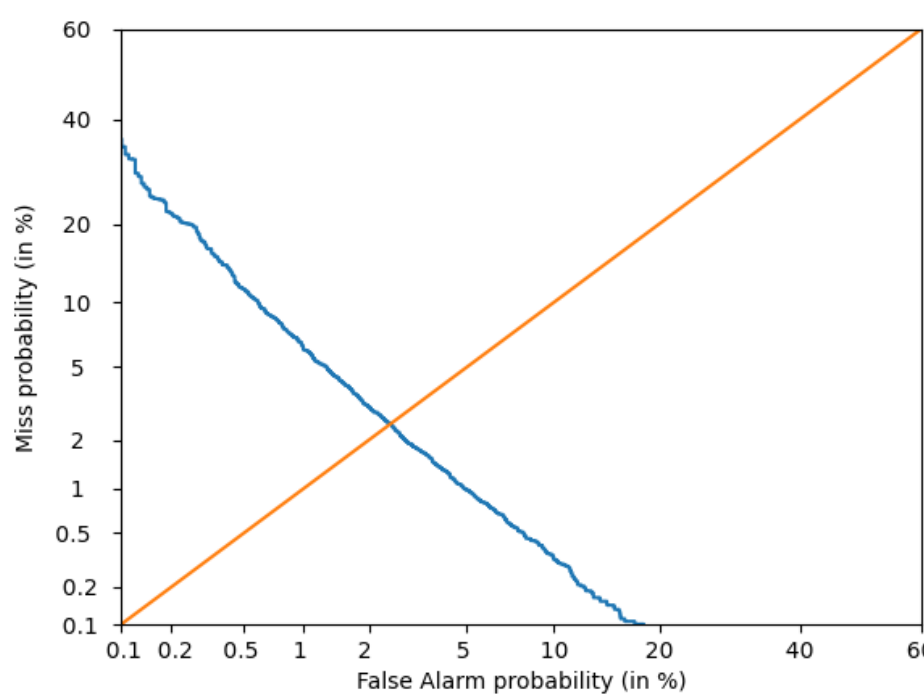
Figure 3. The DET curve of our proposed method.